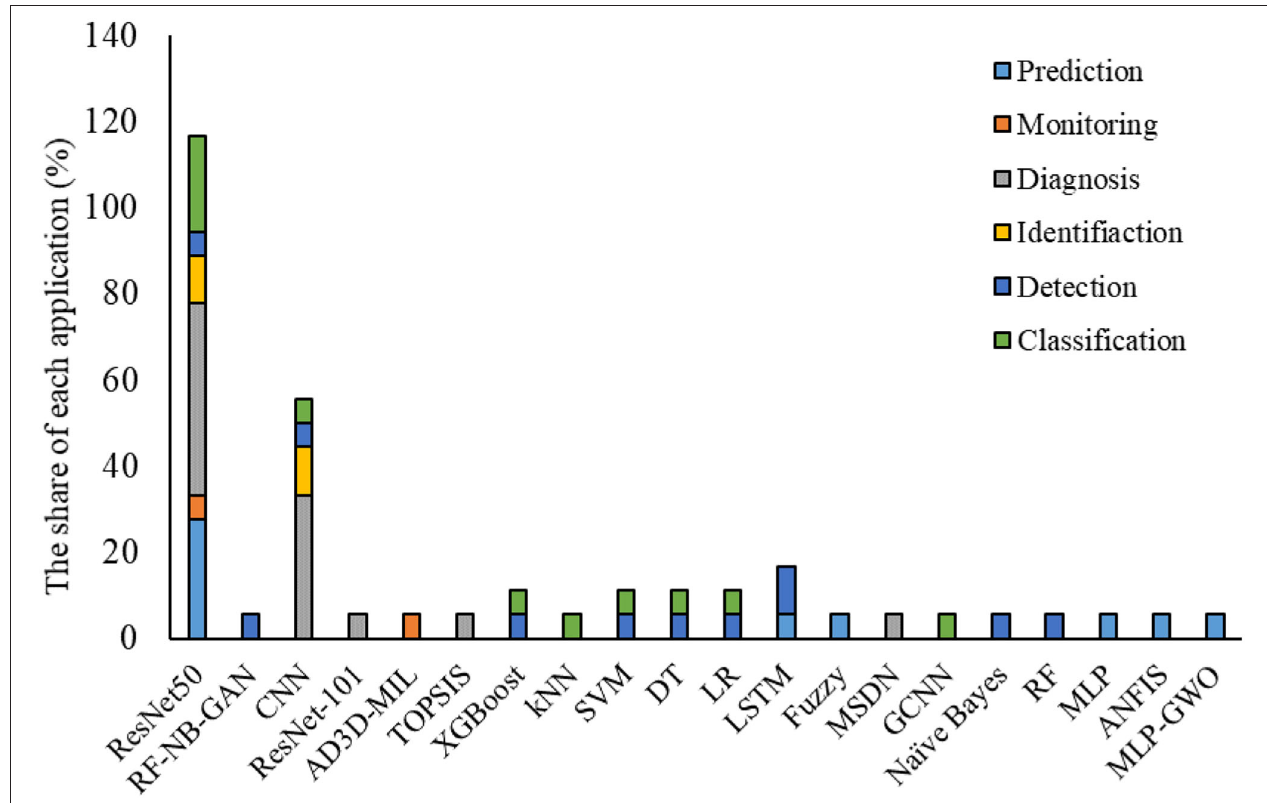
FIGURE 7 | The share of each application (%).